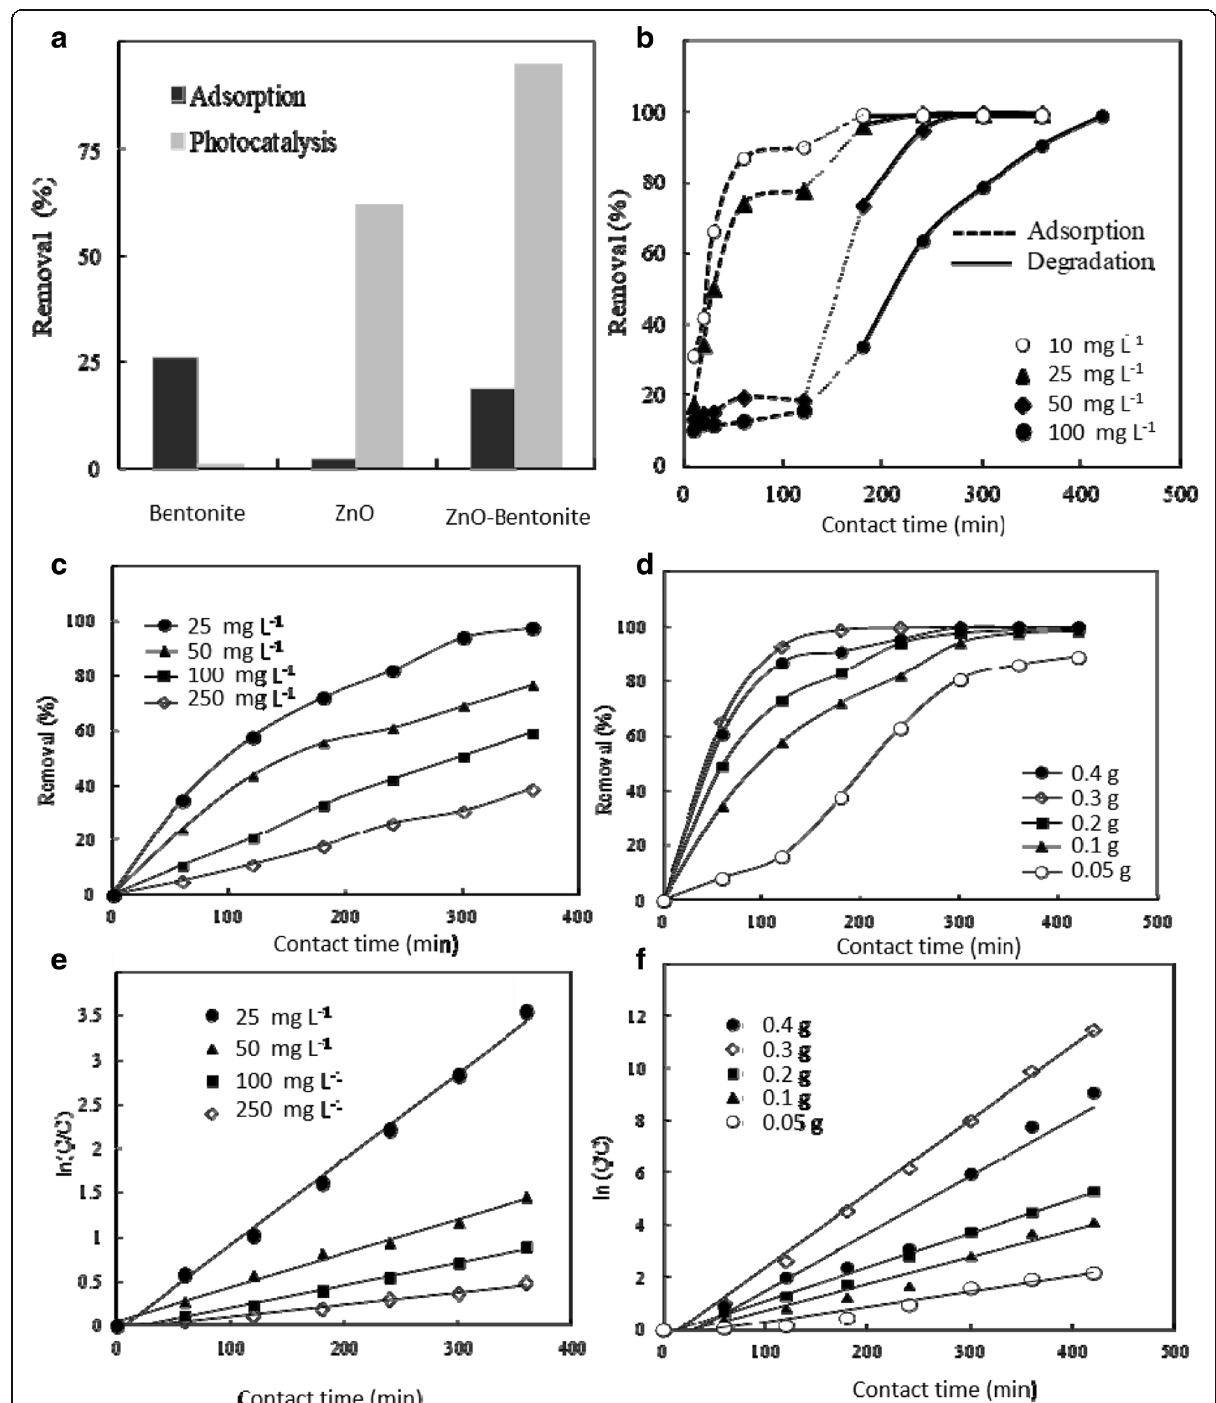
Fig. 3 ( a ) Removal of MB from aqueous solution. Initial MB concentration: 50 mg L − 1 ; Catalyst dose: 2 g L − 1 , ( b ) Removal of MB by adsorption and photo-catalysis under UV-irradiation with time at different initial concentrations of MB. Thin dotted line is used to differentiate adsorption from photocatalysis. Removal percentage of phenol by photo-decomposition under UV-irradiation with time at ( c ) different initial concentrations, ( d ) different catalyst loading ( e , f ) Langmuir-Hinshelwood plots for determination of kinetic rate of photodecomposition, ( e ) different phenol concentrations, and ( f ) different catalyst